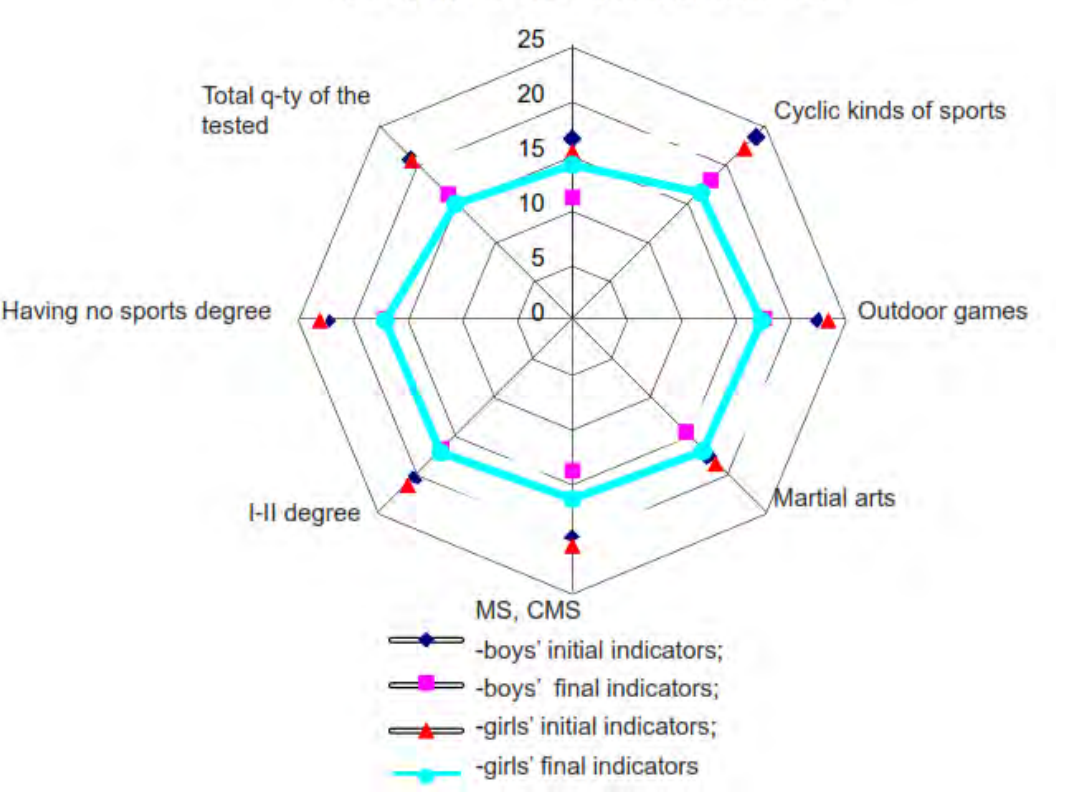
Fig. 11. Indicators, which characterize coordination abilities to vestibular balance of NU PESU first year